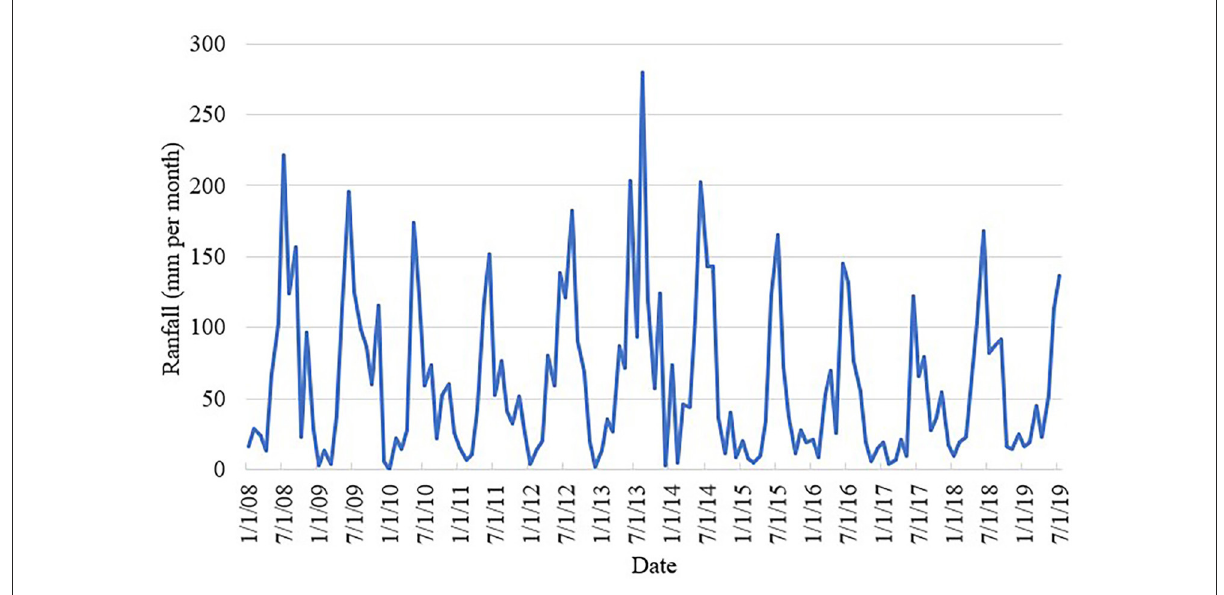
FIGURE4 “Big Six” monthly rainfall from 2008 to